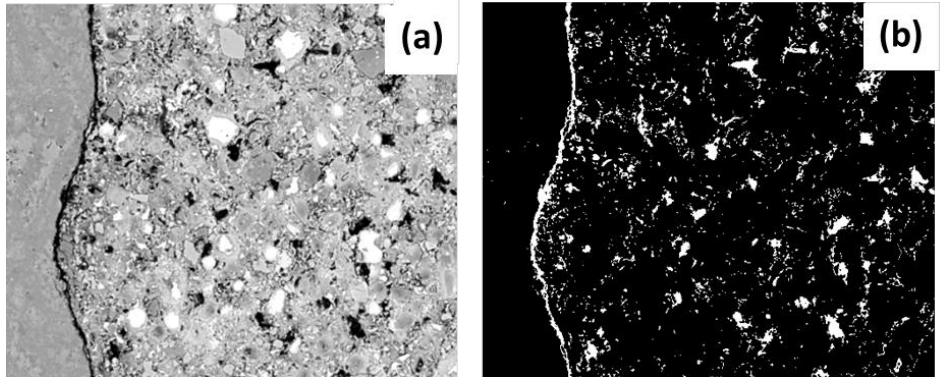
Figure 6. The total porosity of the image ( a ) initial image and ( b ) segmentation and binarization of image after application of threshold segregation.